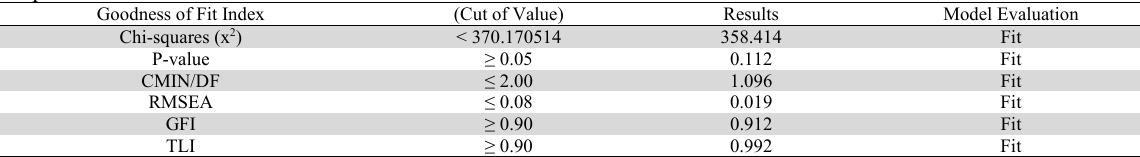
Complete Goodness of Fit